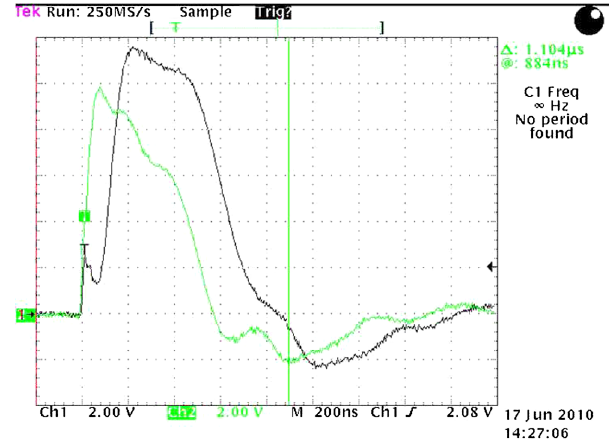
FIG. 41. PFN test circuit—voltage across magnet.